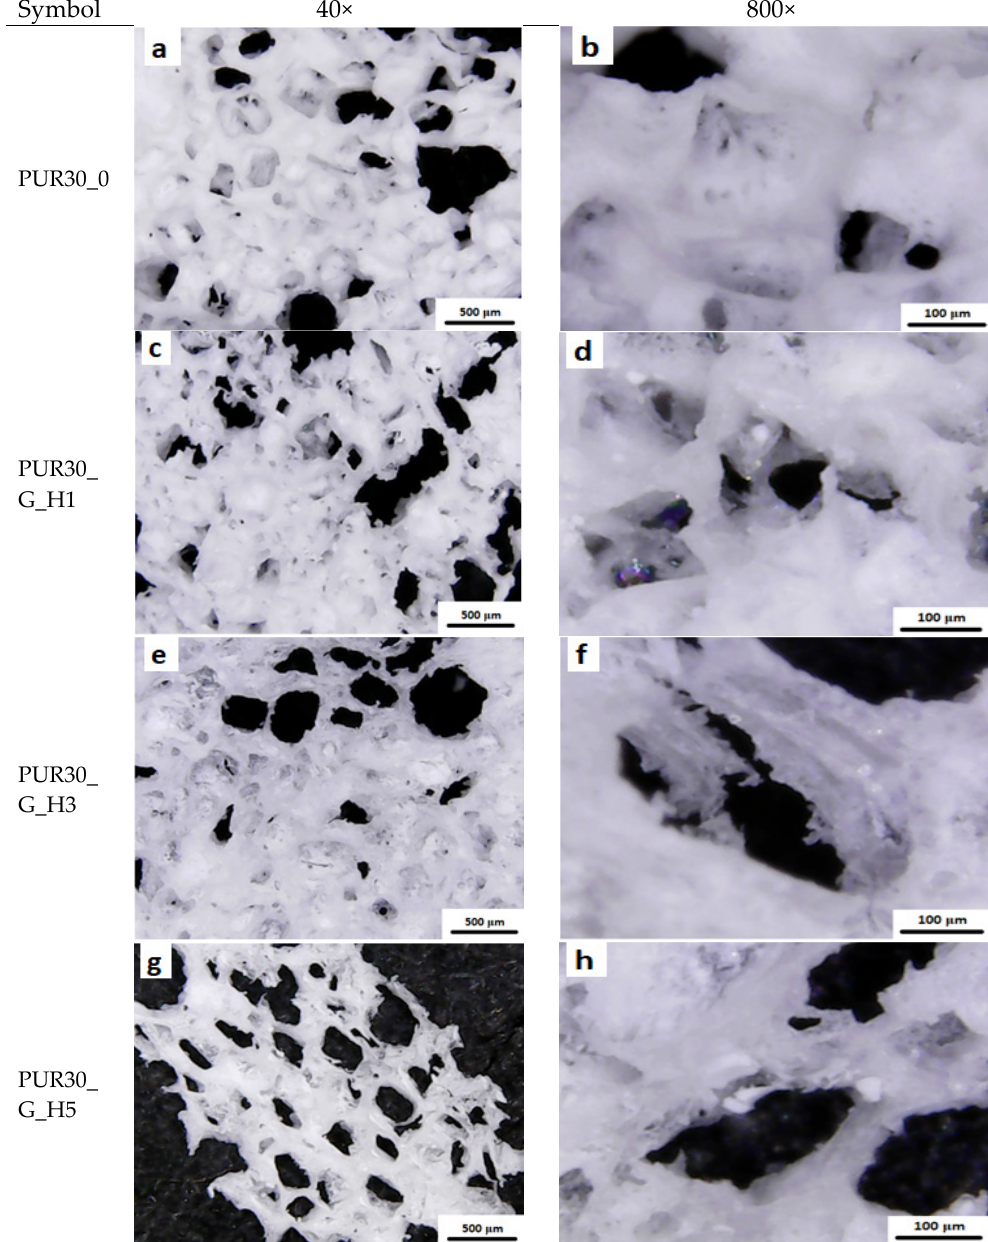
Figure 5. Morphology of scaffolds: ( a , b ) unmodified; ( c , d ) modified with gelatin and 1% HAp; ( e , f ) modified with gelatin and 3% HAp; ( g , h ) modified with gelatin and 5% HAp.